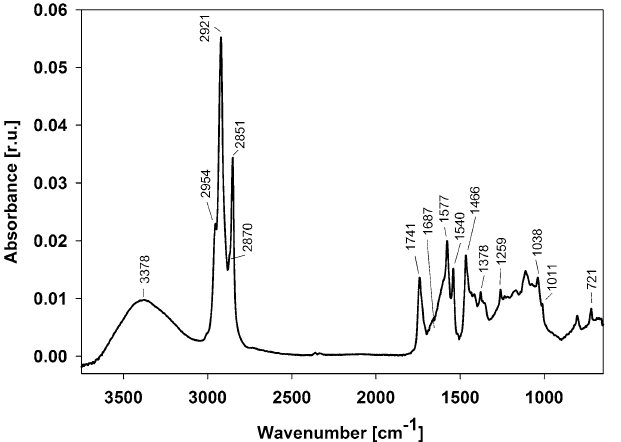
Figure 4. ATR-FTIR spectrum in the (4000–500 cm −1 , mid-infrared region) of gemmatoxanthin. r.u.- relative